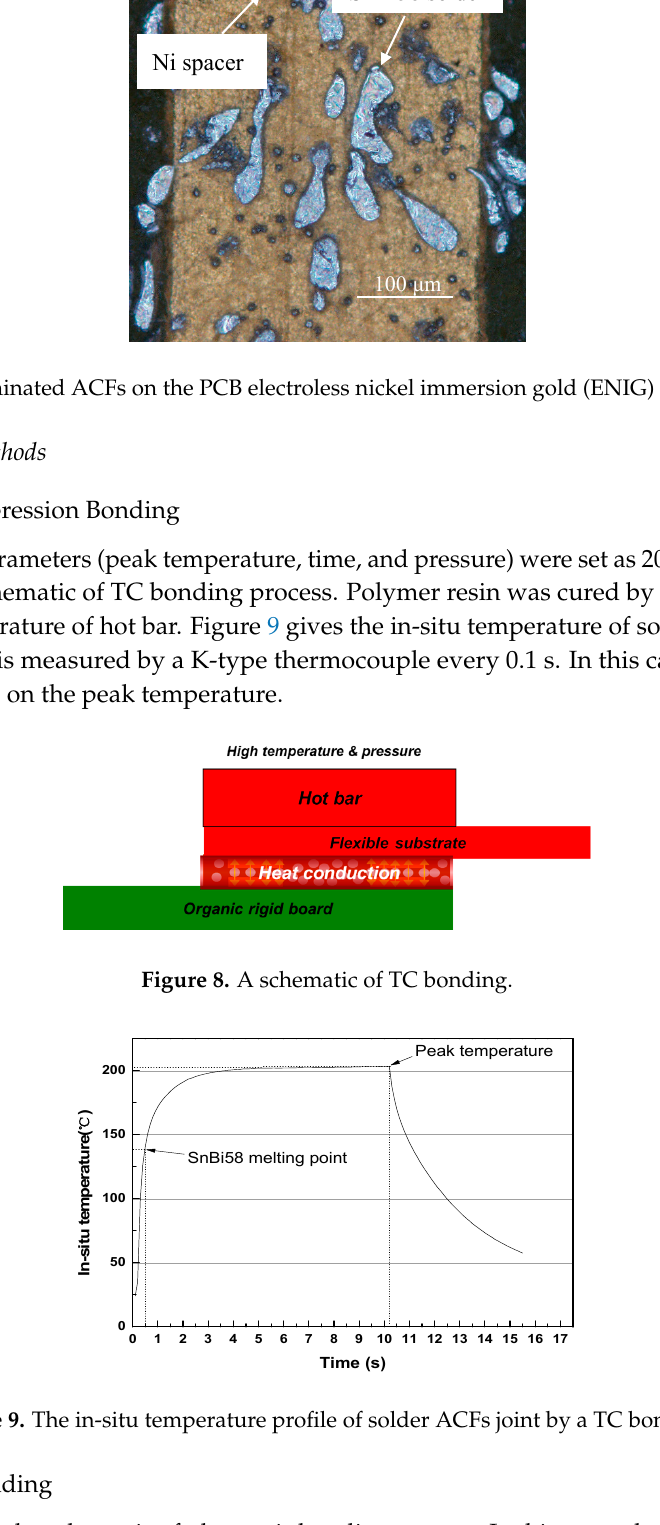
Figure 9. The in-situ temperature profile of solder ACFs joint by a TC bonding.